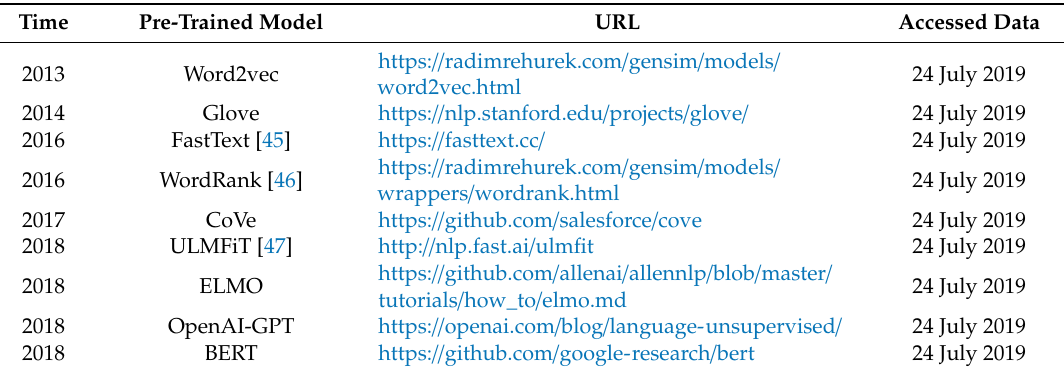
Table 2. Pre-trained models for word